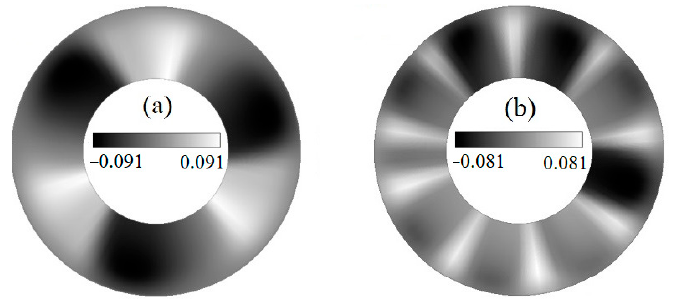
Figure 4. Overview of surface solute concentration fluctuations of 3D oscillatory flows at Re s = Re c = 0. ( a ) Re T = 5 × 10 3 ; ( b ) Re T = 10 4 .